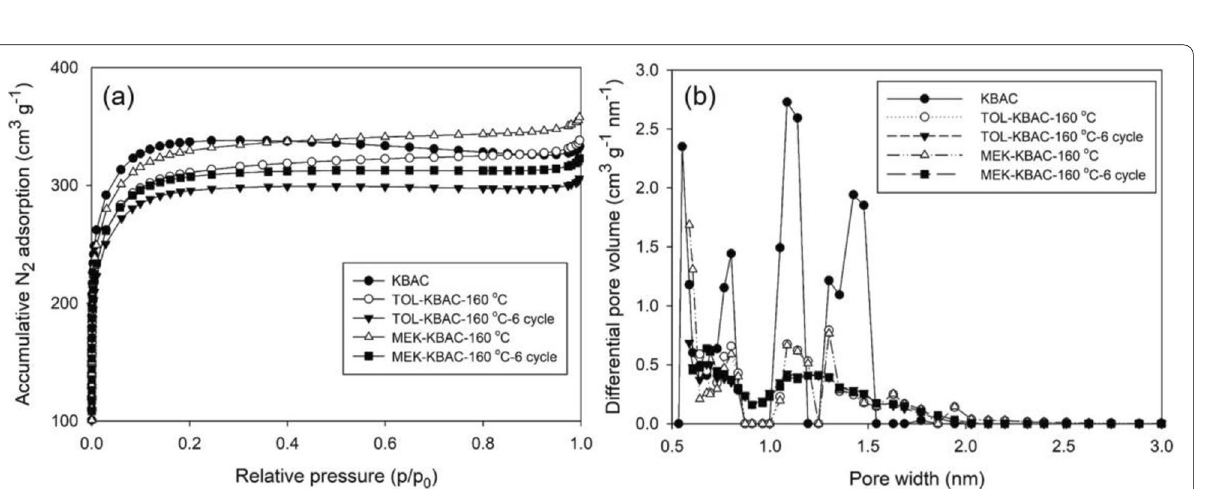
Fig. 4 Pore structure analysis for both virgin and regenerated KBAC samples. a 77 K N 2 adsorption‑desorption curve and b PSD within microporous